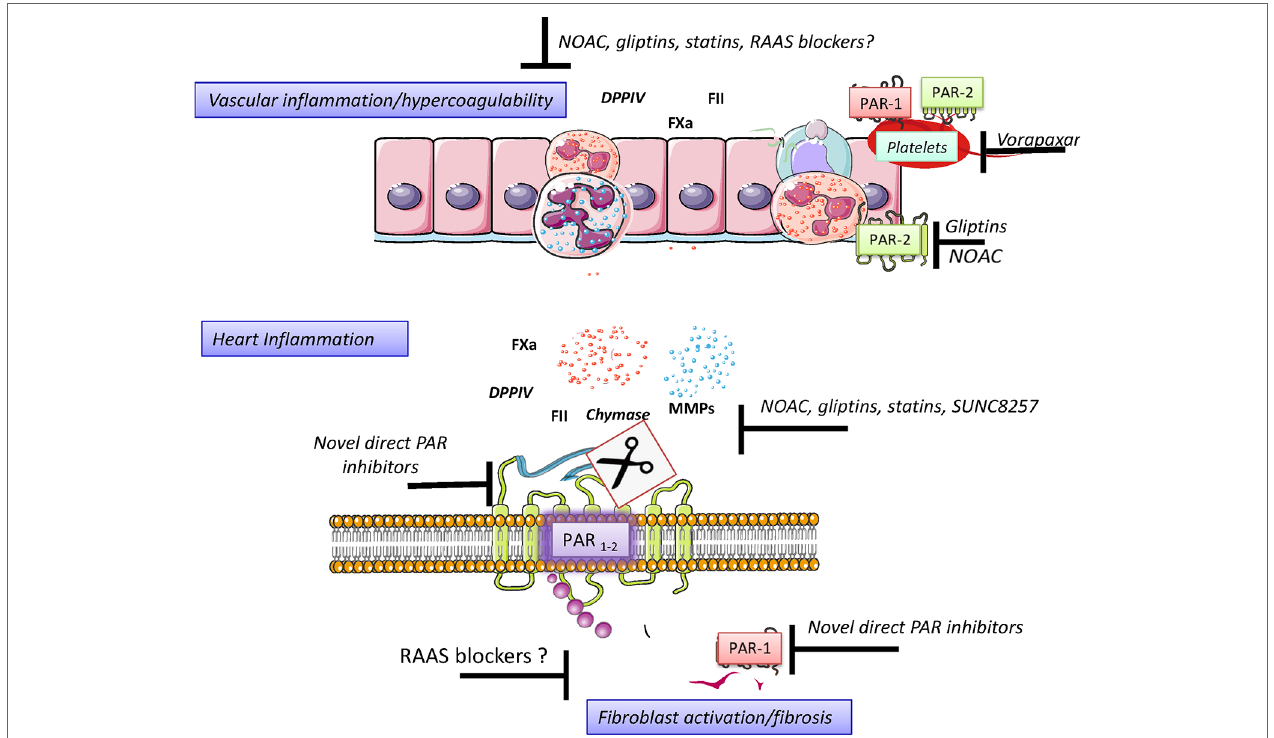
FIGURe 2 | Serine proteases mechanisms of action. Serine proteases are a particular types of endoproteases involved in endogenous processes including the activation of inactive peptide (zymogens; i.e., coagulation cascade), inactivation of bioactive peptides (GLP-1 as DPP-4). Serine protease activity is controlled homeostatically by endogenous inhibitors (serpins). Furthermore, serine protease may also activate specific protease activated receptors (PAR) by cleaving the N-extracellular portion of the receptor and producing a tethered ligand. Such ligand interaction with the specific site of the trans-membrane-portion of the receptor induces G-protein recruitment and intracellular cascade including G-protein-dependent and -independent cascades. Figure created using Servier medical art